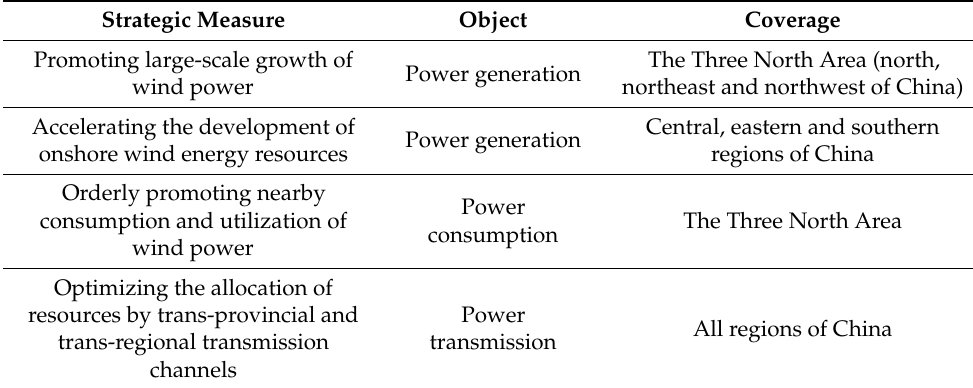
Table 4. Strategic layout of wind power in 2010s.